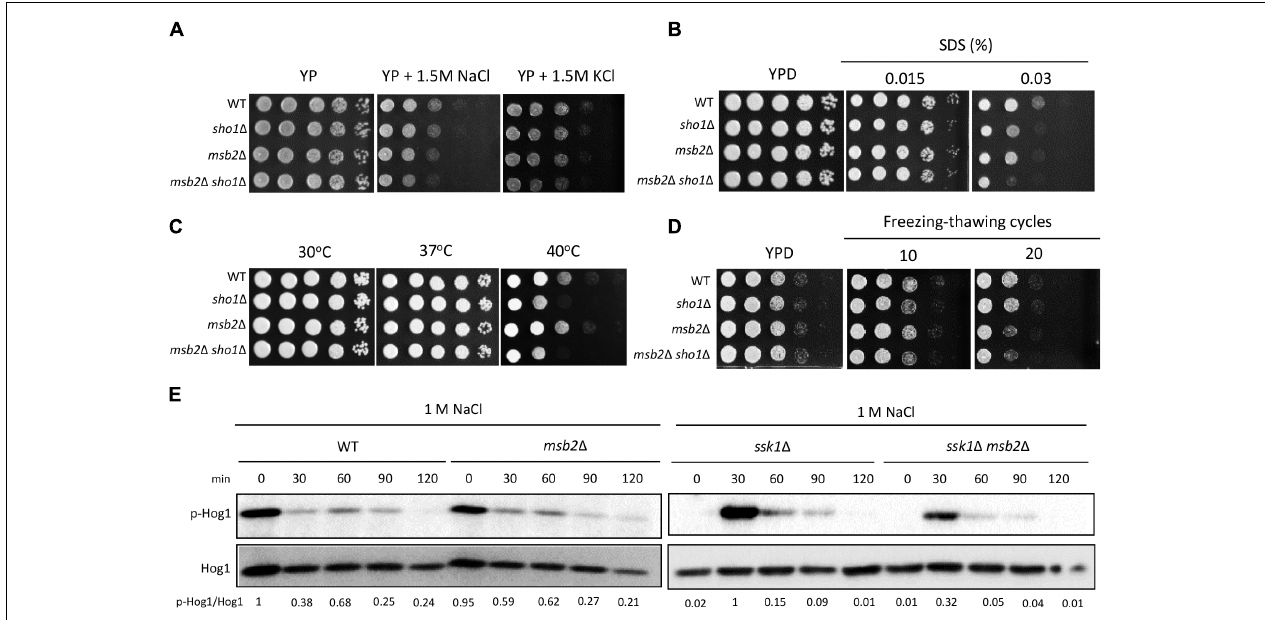
FIGURE 5 | Sho1 and Msb2 are required for the membrane stability. (A,B) Wild-type (WT; H99), sho1 (cid:49) (YSB1719), msb2 (cid:49) (YSB3191), and sho1 (cid:49) msb2 (cid:49) (YSB3605) strains were grown overnight at 30 ◦ C in the liquid YPD medium. The strains were 10-fold serially diluted (1–10 4 dilutions) and spotted 3 µ L on YP or YPD medium containing the 1.5-M concentration of NaCl or KCl or SDS. The plates were incubated at 30 ◦ C for 2 days and photographed. These spot assays were repeated more than three times and one representative image was shown here. (C) Each strain was 10-fold serially diluted (1–10 4 dilutions), spotted onto solid YPD medium, and further incubated at 30, 37, and 40 ◦ C. These spot assays were repeated more than three times and one representative image was shown here. (D) Strains were repeatedly frozen and thawed, then 10-fold serially diluted (1–10 4 dilution), and spotted onto YPD medium. The plates were further incubated for 2–3 days and photographed. This experiment was repeated twice and one representative result was shown here. (E) Strains were grown to the mid-logarithmic phase and exposed to 1-M NaCl for the indicated time. The phosphorylation levels of Hog1 were monitored using anti-P-p38 antibody. The blot was stripped and used for detection of Hog1 with polyclonal anti-Hog1 antibody as a loading control. These western blot analyses were repeated twice and one representative result was shown